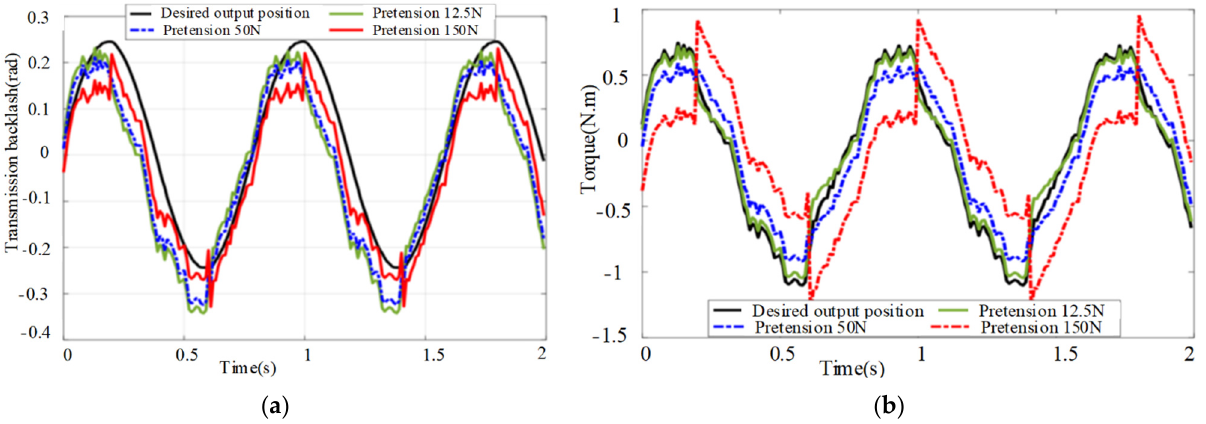
Figure 10. The displacement and torque transmission characteristics of cable-pulley systems exert- ing different pretensions: ( a ) Transmission backlash of the cable-pulley system exerting different pretensions; ( b ) Output torque of the cable-pulley system exerting different pretensions. Table 4. Transmission error of position and torque of cable pulley with the pretension of 50N.